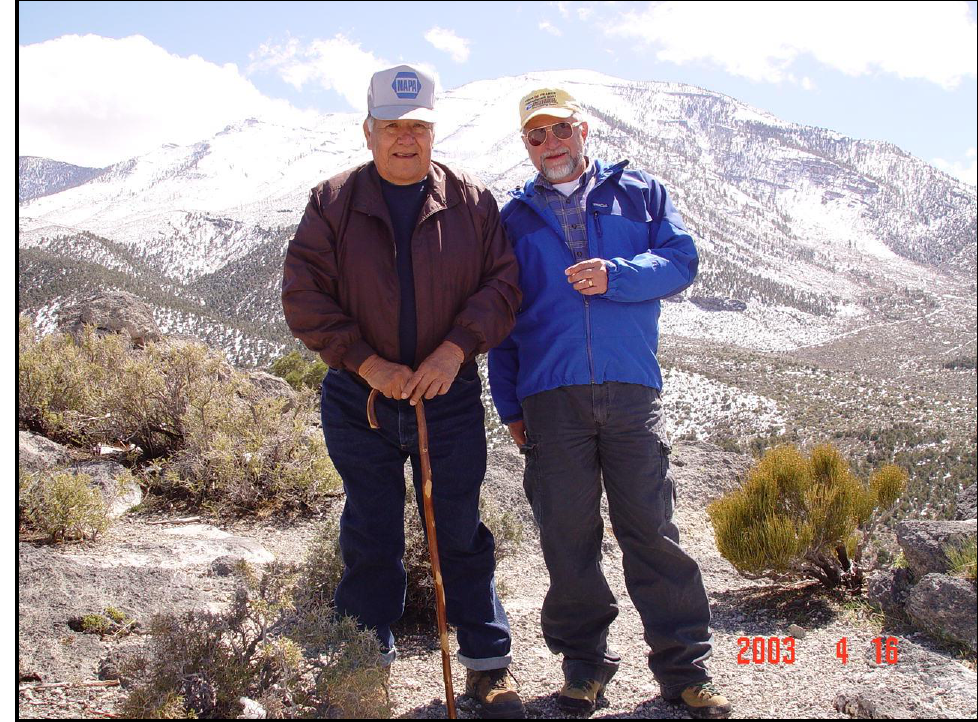
Figure 25. Religious Leader Larry Eddy and Rich Stoffle at Spring Mountains [45].